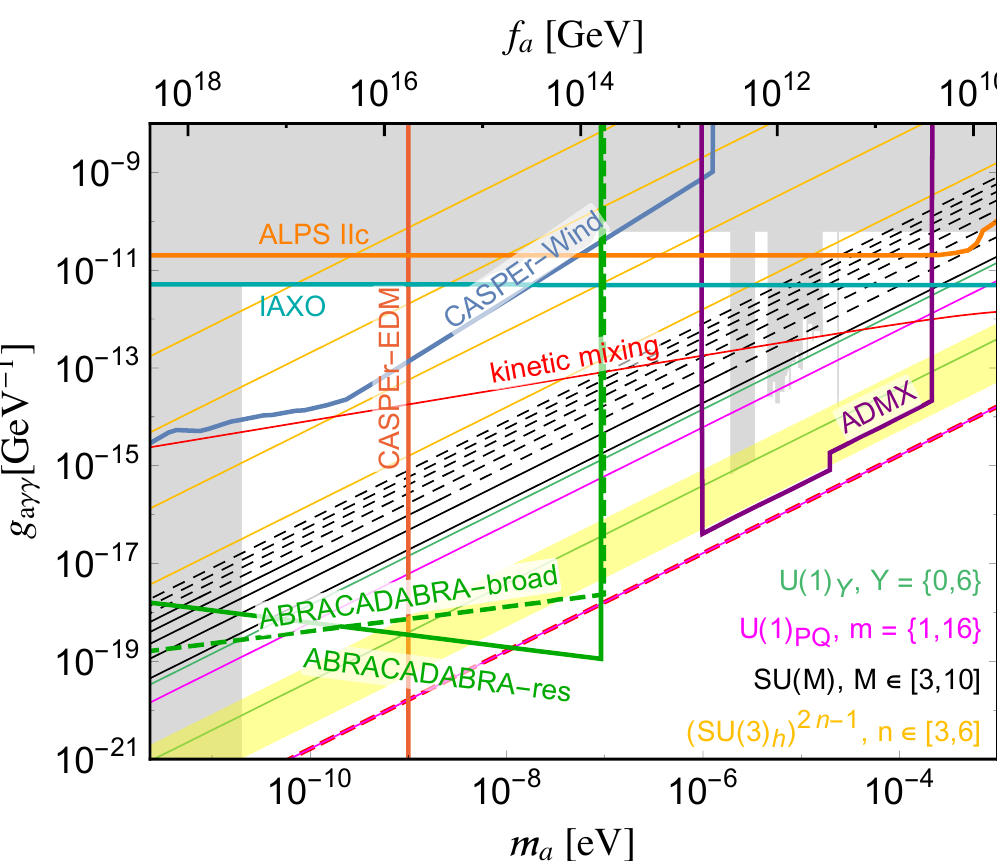
Figure 1 . Parameter space of the axion coupling with photons. The gray regions are existing limits. Thin slanted lines represent the predictions in models of sections 2 (black), 3 (amber), and 4 (red) and appendix C (green, magenta) are shown explicitly. Regions bounded by colored lines show sensitivity of upcoming experiments, ALPS II (orange), IAXO (teal), CASPEr-Wind (blue), CASPEr-EDM (red), ABRACADABRA (green) and ADMX (purple). Further details for the plot can be found in the text.